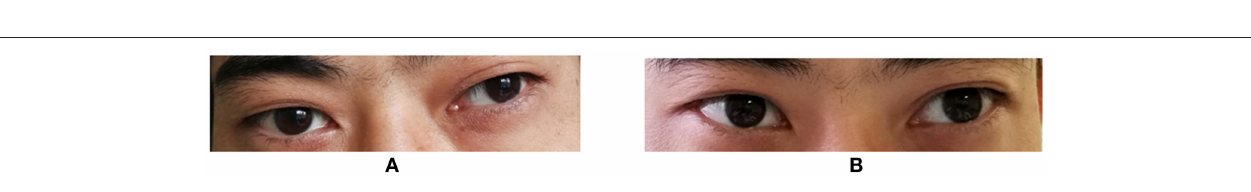
FIGURE 1 | Eyelid symptoms before and after the neostigmine test. (A) Before the test. Both eyes, especially the left one, showed ptosis. (B) 30min after the test. Ptosis improved dramatically, to a greater extent in the left eye. (C) 60min after the test. Both eyelids recovered nearly to a normal state. Relative score = 100% (positive). In the neostigmine test, the most severely affected muscle group was chosen, the muscle power at baseline was scored, then neostigmine (1.5mg) and atropine (0.5mg) were administered intramuscularly. The patient was then evaluated every 10min for a total of 60min. Relative Score = (score at baseline − score when improvement was greatest after injection) / (score at baseline) × 100%. Relative scores ≤ 25% were classified as negative; > 25% and < 60%, suspected positive; and ≥ 60%, positive.